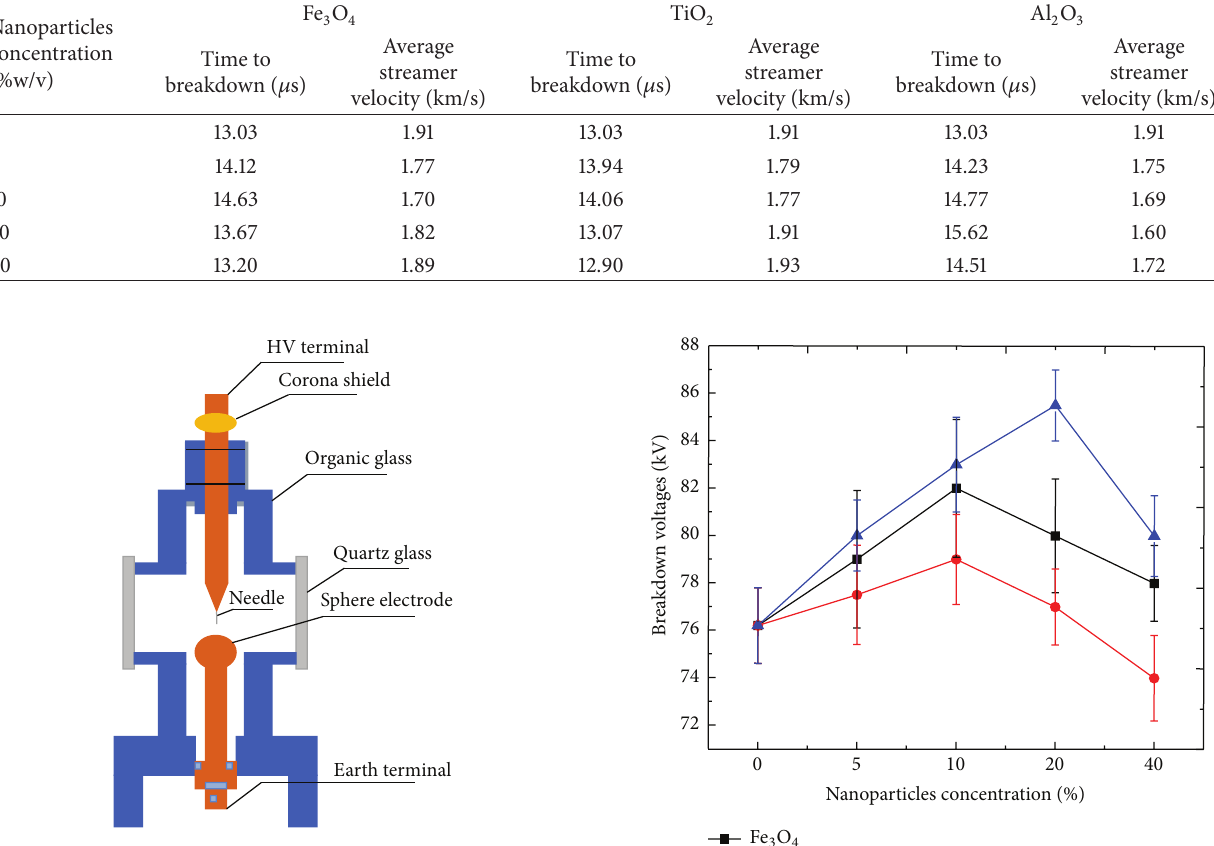
Figure 1: Test cell for impulse breakdown measurement.